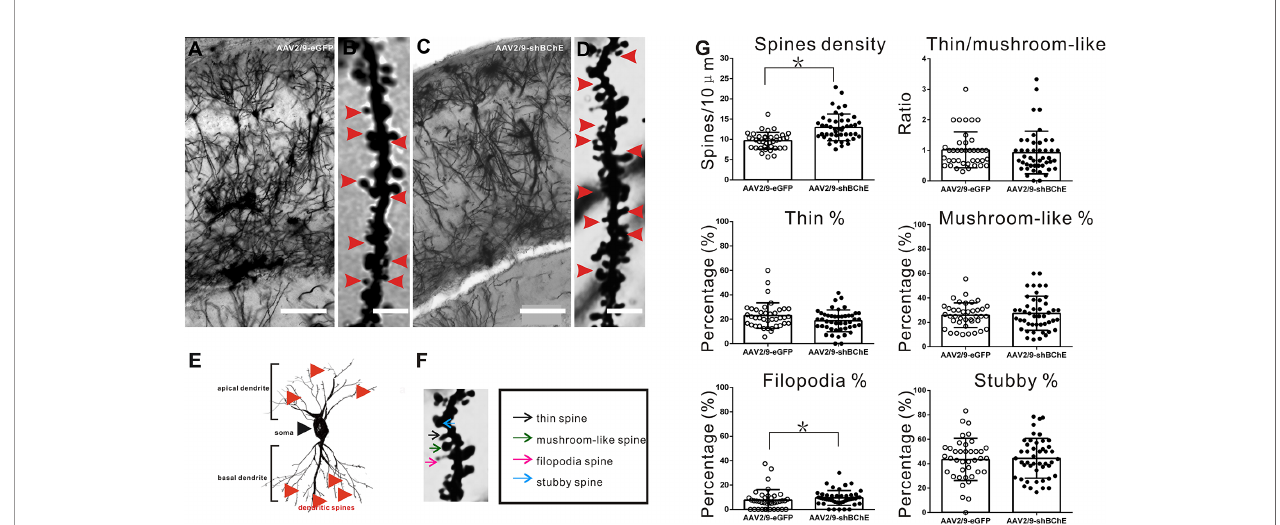
FIGURE 4 | BChE knockdown in the hippocampal CA1 region signi fi cantly increased the total spine density on pyramidal dendrites after CFC. (A – D) Representative Golgi-Cox impregnated spines in the hippocampal CA1 area in the AAV2/9-shBChE and control AAV2/9-eGFP groups 24 h after training. A and C, scale bar: 100 m m. B and D, scale bar: 2.5 m m. (E) Representative images showing the morphology of apical and basal spines. (F) Representative images of the morphology of thin, mushroom-like, fi lopodia and stubby spines. (G) Quanti fi cation of the total density of spines in the AAV2/9-shBChE and control AAV2/9-eGFP groups. Signi fi cant differences were observed between the groups ( p < 0.001, * p < 0.05; n = 39 – 46 dendrites from 3 mice per group). The results also showed that the percentage of fi lopodia spines increased when BChE was knocked down ( p = 0.038, * p < 0.05; n = 39 – 46 dendrites from three mice per group). The data are presented as the mean ±